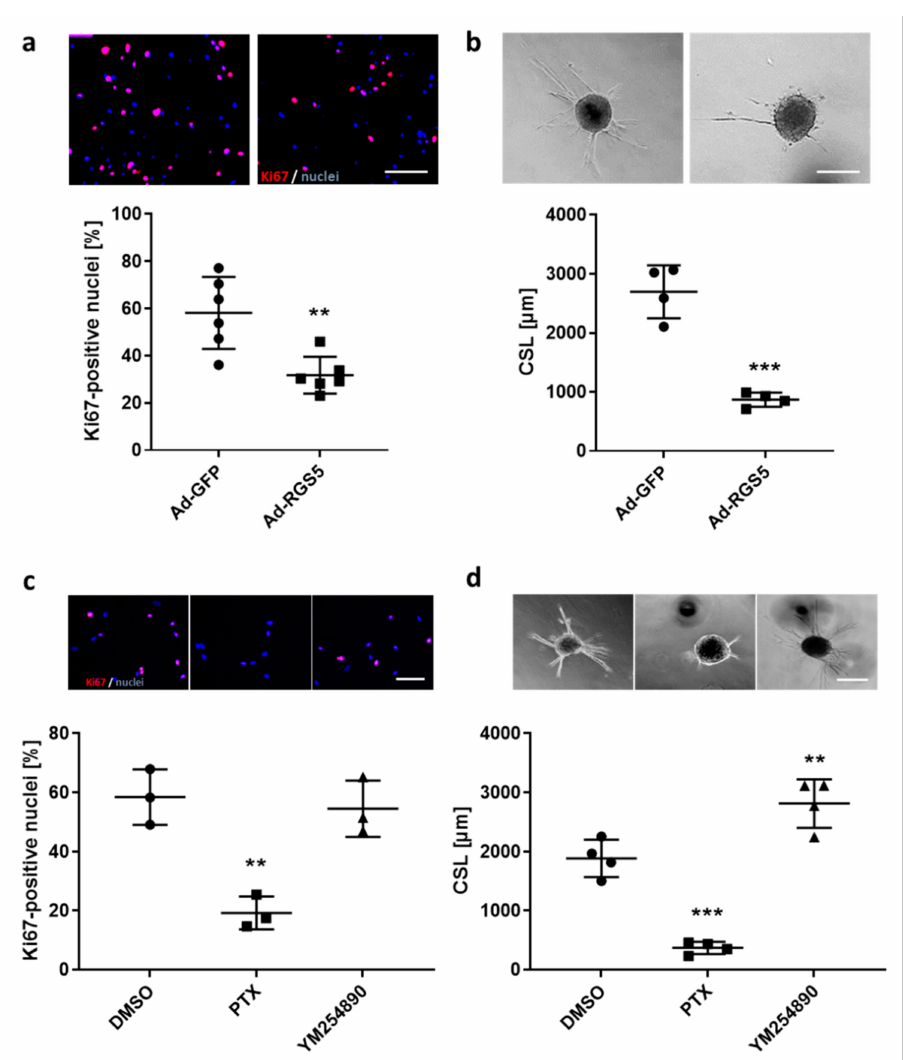
Figure 7. Overexpression of RGS5 and inhibition of G α i/o limits proliferation and migration of human VSMCs . ( a ) Immunofluorescence-based detection of the proliferation marker Ki67 (Ki67: red, DAPI/nuclei: blue, scale bar: 200 µ m) in HUASMC overexpressing GFP (Ad-GFP) or RGS5 (Ad- RGS5) after culture for 24 h (** p < 0.01, n = 6). ( b ) Analysis of HUASMC migration originating